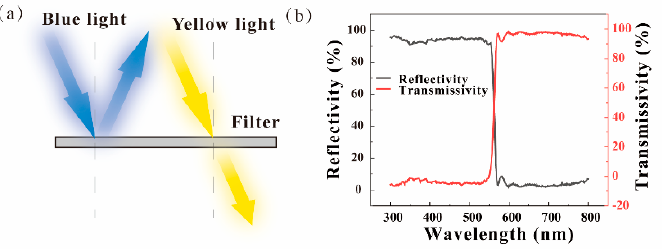
Figure 1. ( a ) Schematic diagram of the filter; ( b ) index of reflectance and transmission versus wavelength.